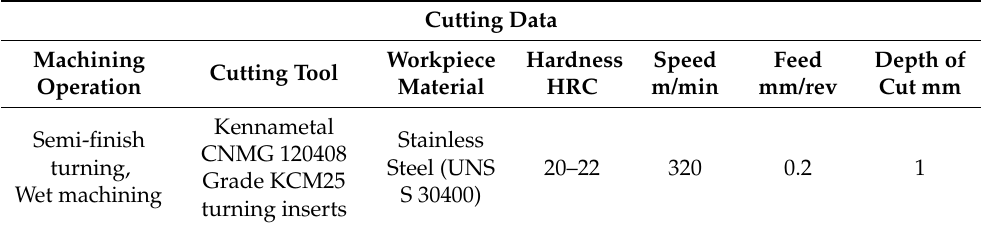
Table 2. Cutting parameters used in the experiments.